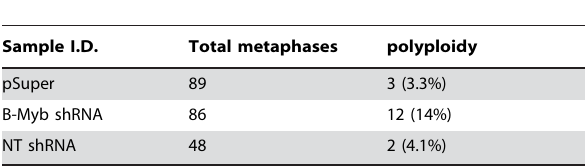
Table 3. Frequency of polyploidy